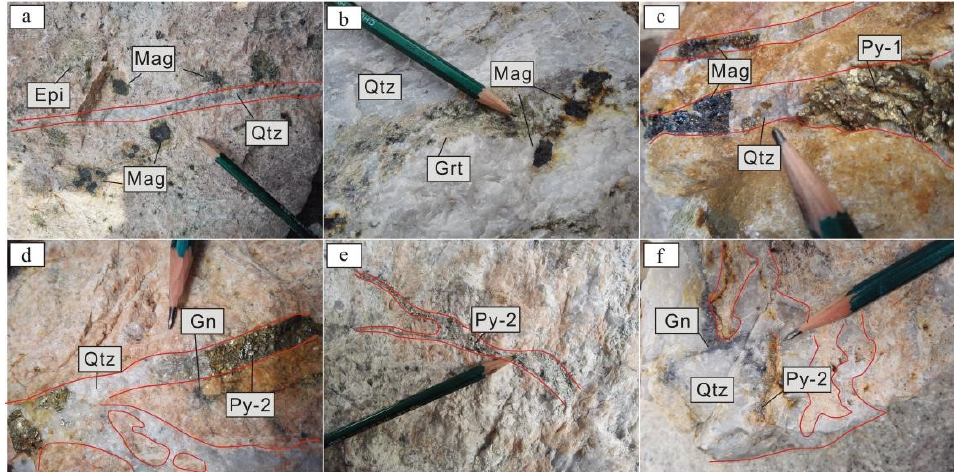
Figure 5. Representative photos of hand-specimens from the Dongping deposit: ( a ) Potassic rocks containing euhedral magnetite are crosscut by quartz vein; ( b ) Epidote, garnet, and magnetite coexist in quartz vein; ( c ) Garnet-magnetite-pyrite-quartz vein crosscut potassic rock; ( d ) Polymetallic sulfide quartz vein containing pyrite; ( e ) Quartz vein containing fine-grained pyrite aggregates; ( f ) Irregular quartz vein containing galena and pyrite. Epi—epidote; Gn—galena; Grt—garnet; Mgt—magnetite; Py—pyrite,